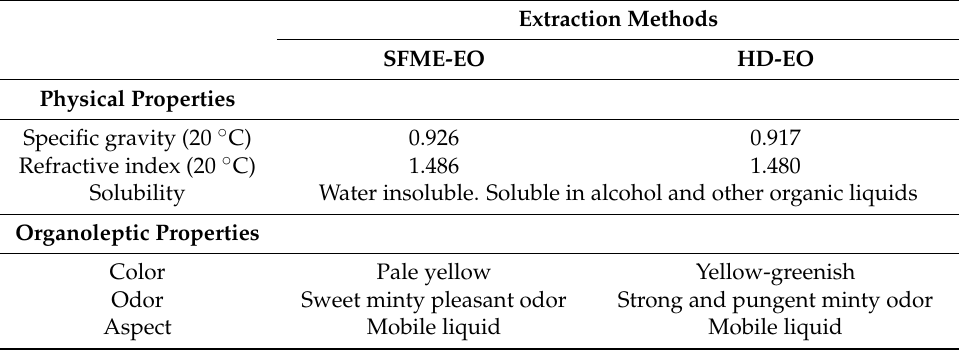
Table 1. Physical and organoleptic properties of sweet basil EO obtained by SFME and HD.